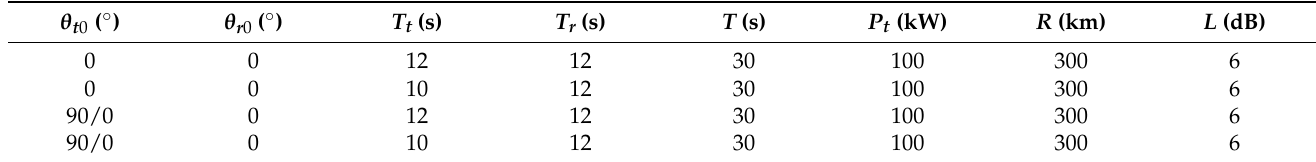
Table 1. The important parameters of the radar and EW